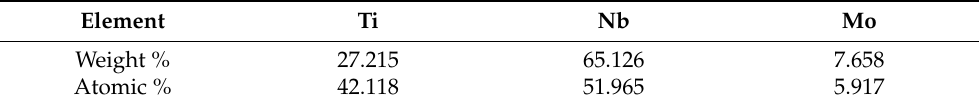
Table 4. Spectrum1: Concentration Ratio of Alloying Elements in a Composite’s